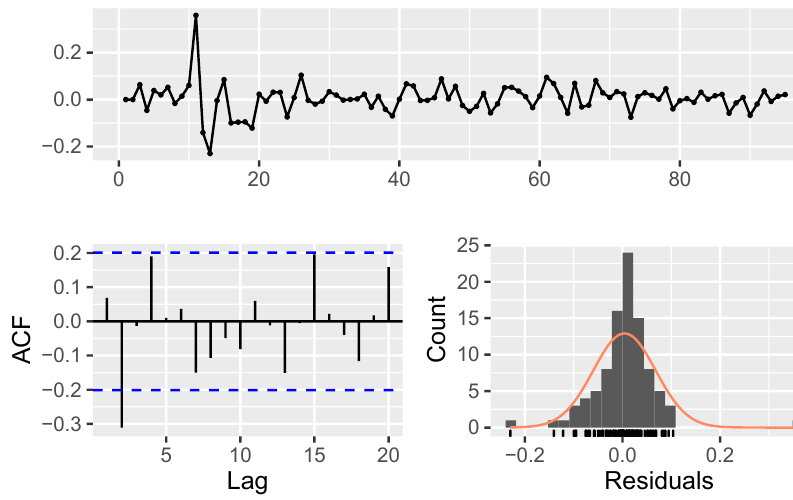
Figure A5. Residuals from ARIMA(1,2,2) for Stock